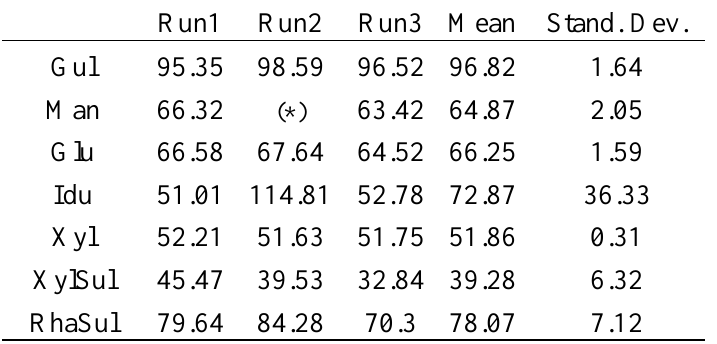
Table 5. Measured angle (degrees) between the least squares plane through the pyranose ring of the ligands and the plane of the Trp243 side indole of